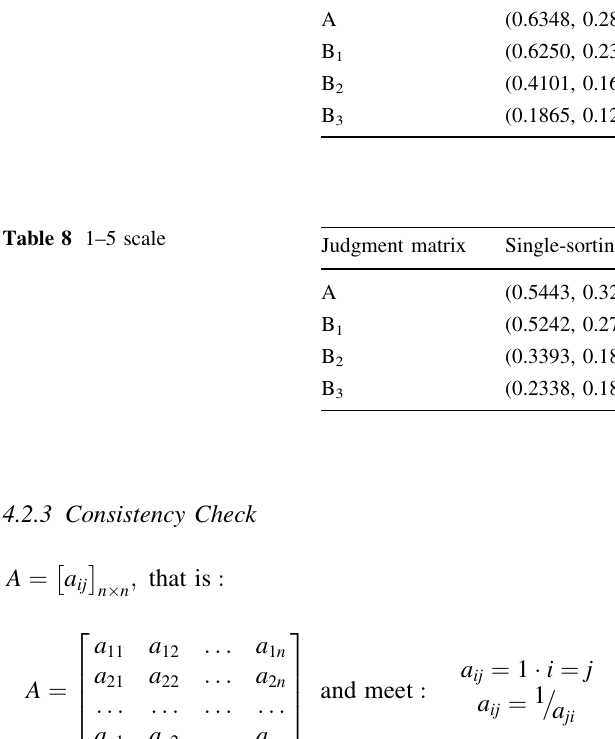
Table 7 1–9 scale Judgment matrix